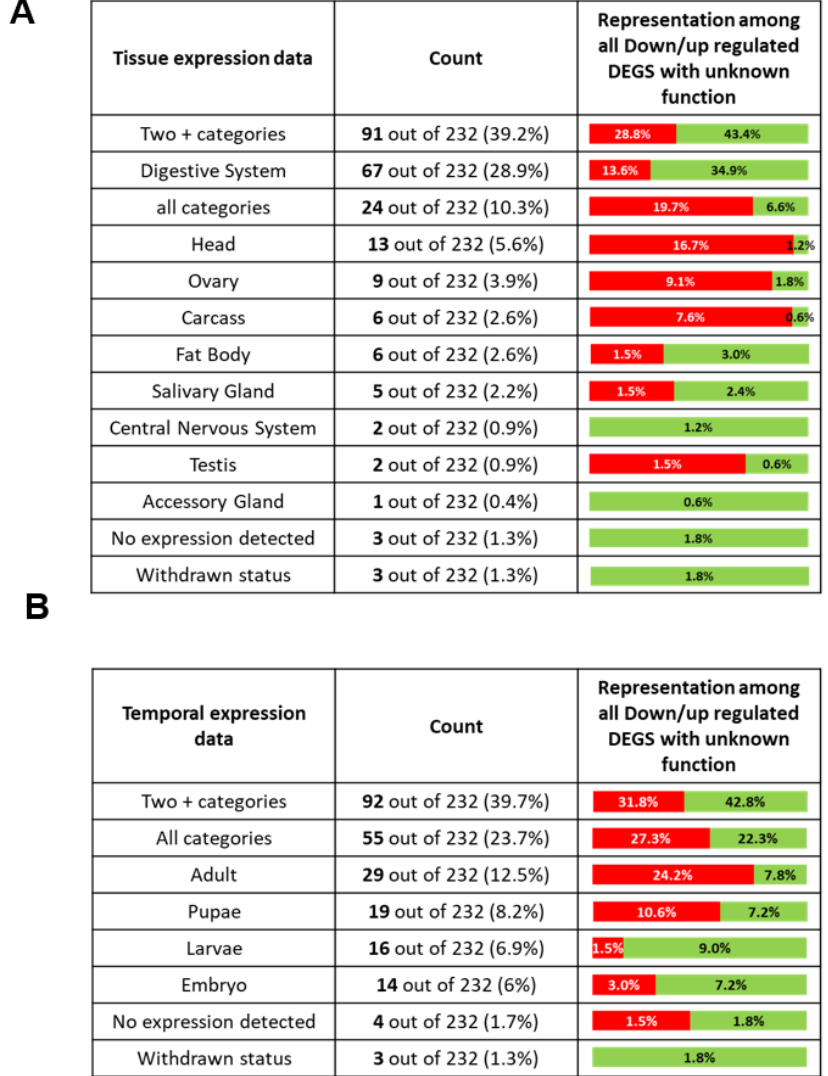
Figure 4. Breakdown of the RNA-seq profile of all DEGs with unknown function (modENCODE data). Two categories were addressed: “tissue expression data” (PRJNA75285) and “temporal expression data” (PRJNA75285). A gene is considered to be predominantly expressed in a specific